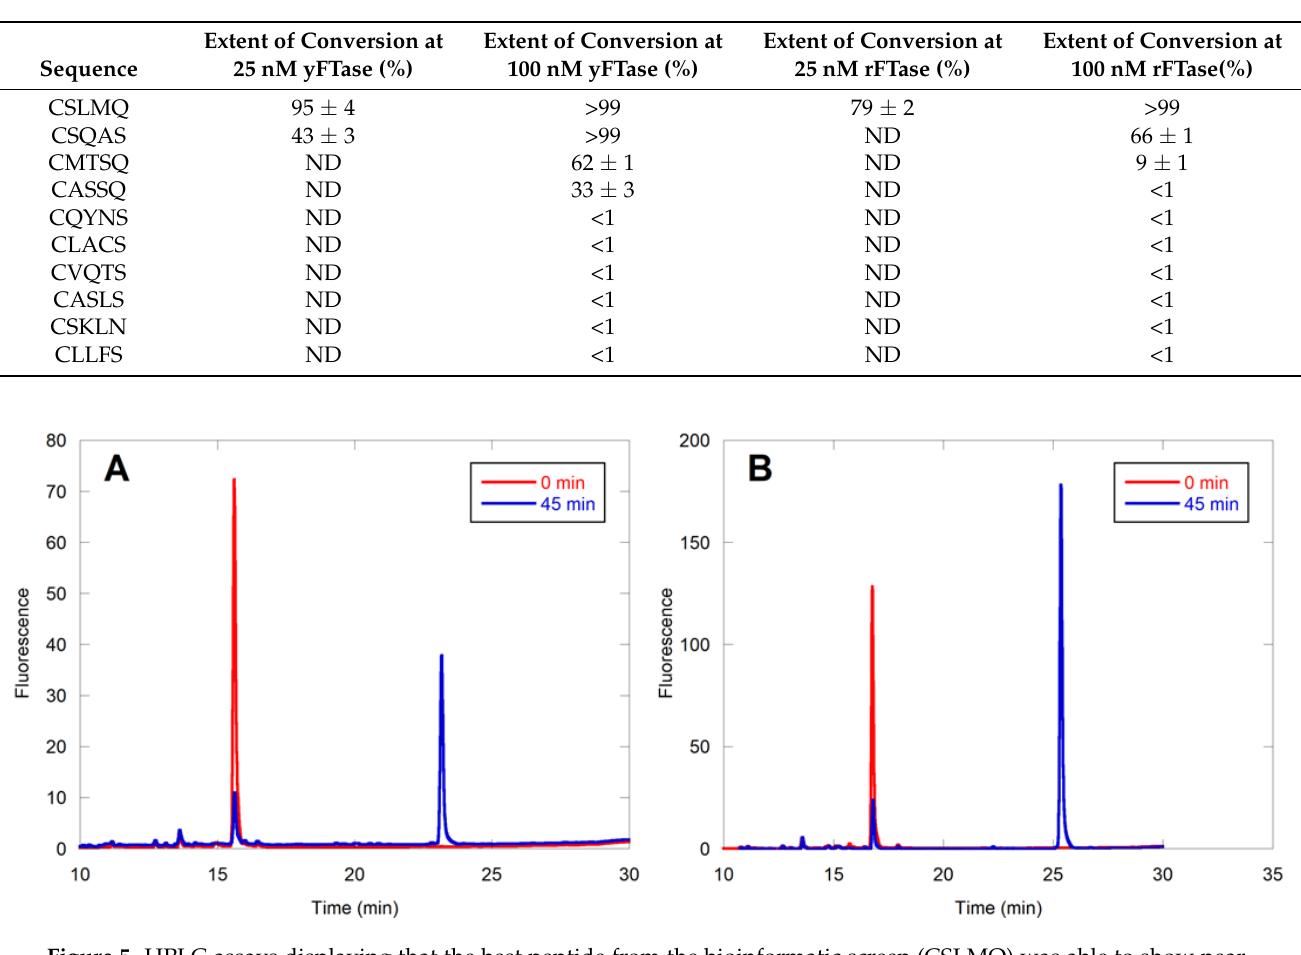
Table 3. Percent farnesylation of CaaaX peptides derived from mammalian genome. Each value is the result of triplicate experiments. ND = not determined.